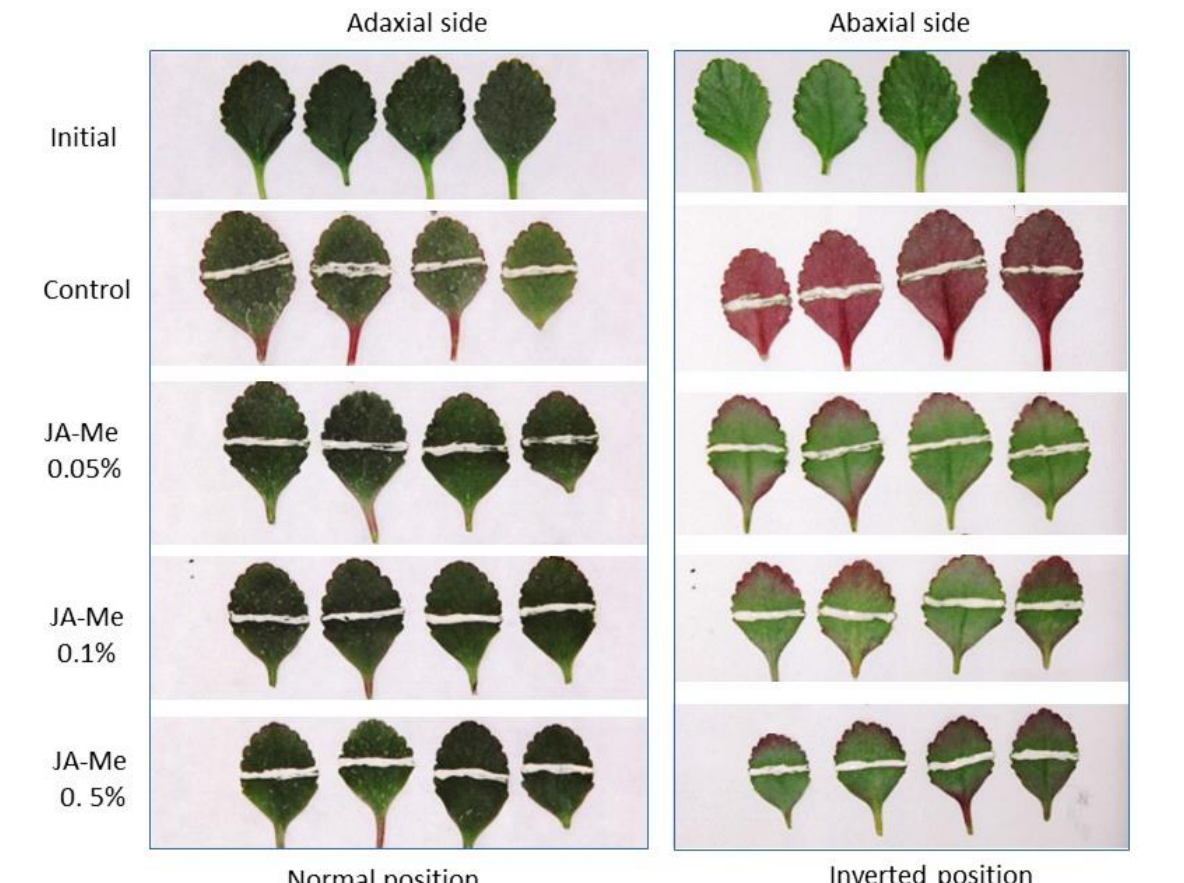
Figure 2. Effect of JA-Me applied to the adaxial or abaxial side of detached leaves of K. blossfeldiana on anthocyanin accumulation. After the application of JA-Me to the adaxial side and the abaxial side of detached leaves, the treated leaves were kept in natural light conditions for 4 days in the positions of the abaxial surface on the lower side (normal, natural position) and the adaxial surface on the lower side (inverted position). Pictures contain the abaxial surface ( left ) and the abaxial surface ( right ) of the detached leaves .